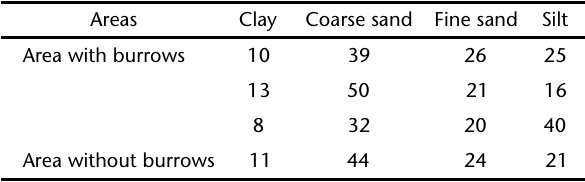
Table II. Soil texture analyses (%) in areas with and without burrows of P. defossus in Lami, Porto Alegre. Areas Clay Coarse sand Fine sand Silt Area with